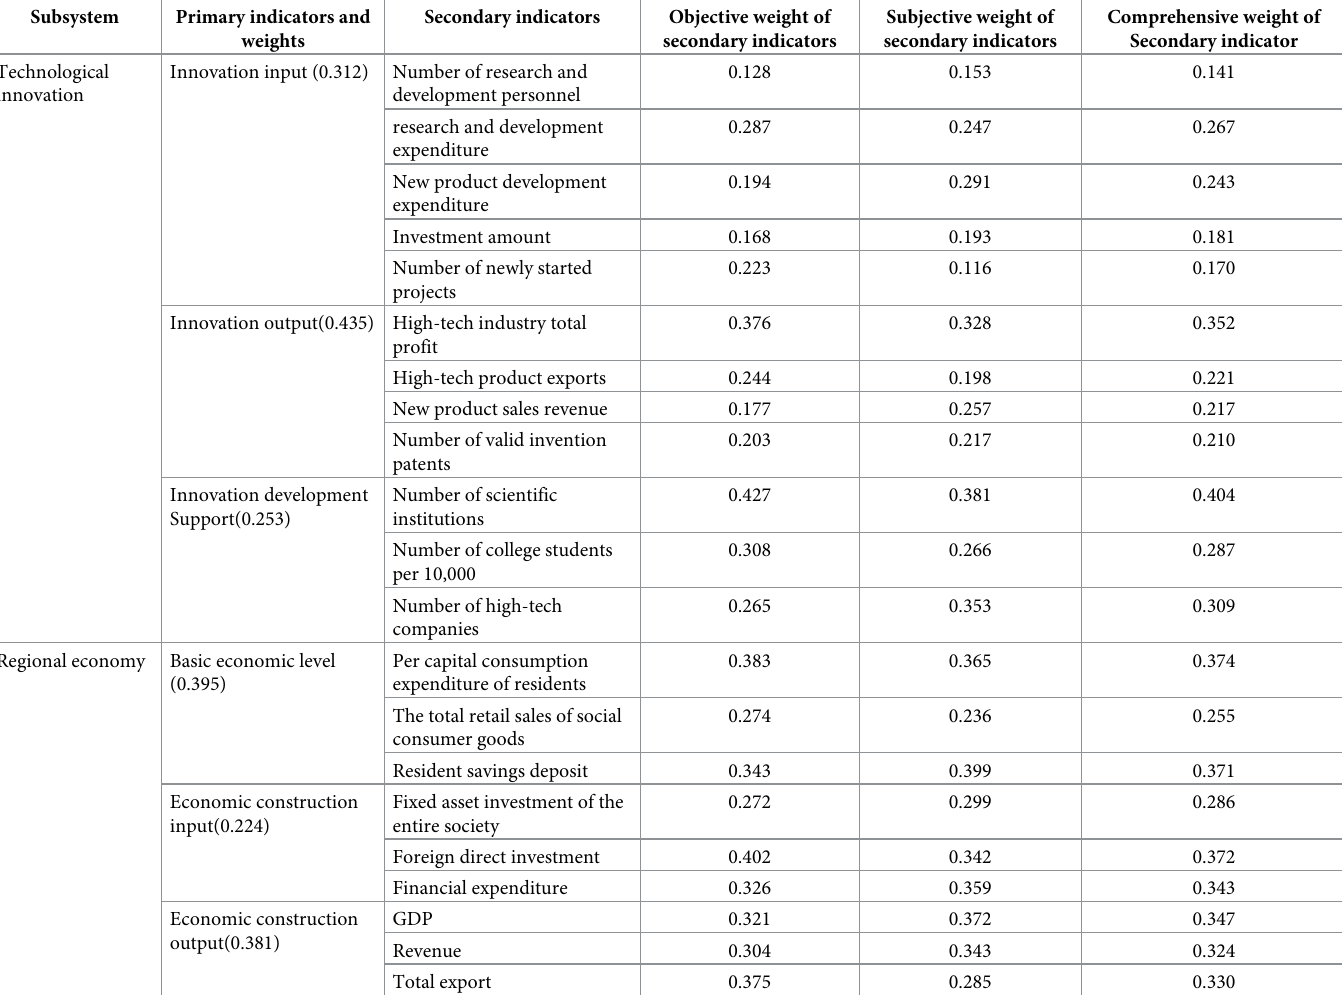
Table 1. Indicator classification and index weights of the high-tech industry subsystem and regional economic subsystem.